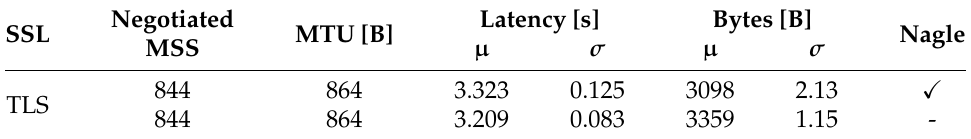
Table 3. Performance-enhancing proxy and